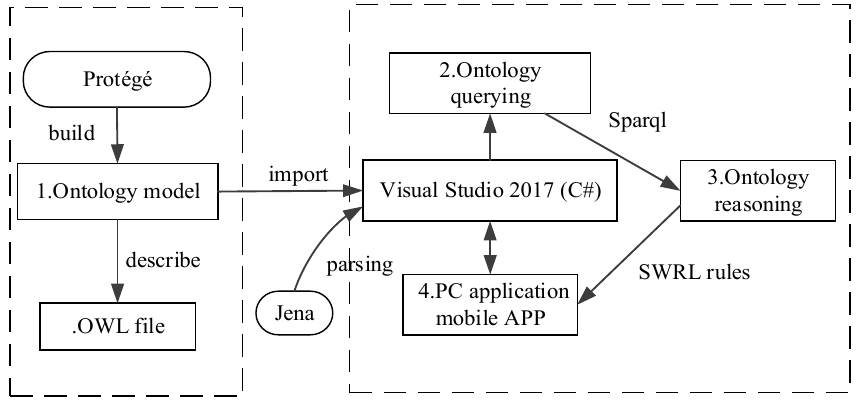
Figure 2. The development flow of ontology-based rollover assessment and decision support method.